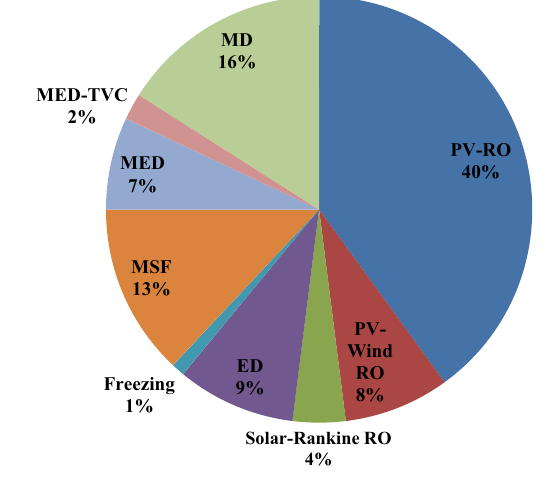
Fig. 24 Contribution of different desalination methods combined with solar sources (Ayoub and Malaeb 2012)